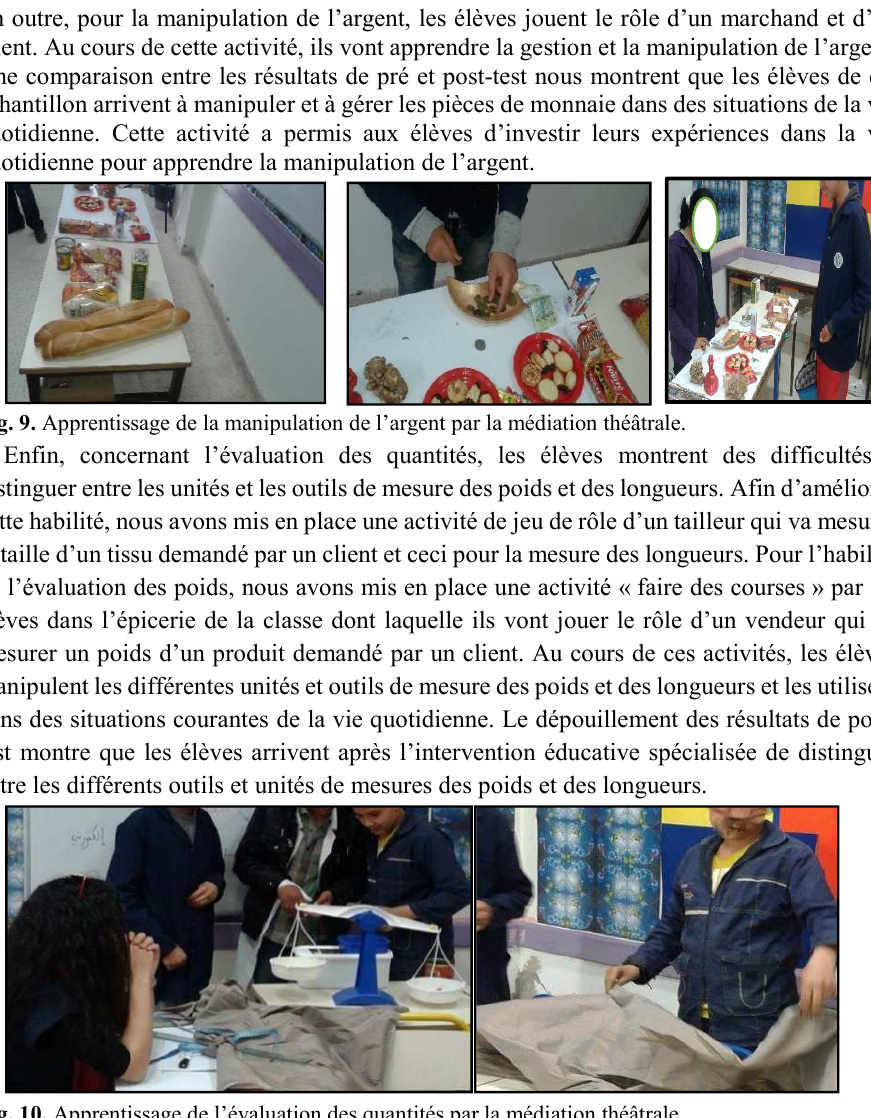
Fig. 10. Apprentissage de l’évaluation des quantités par la médiation